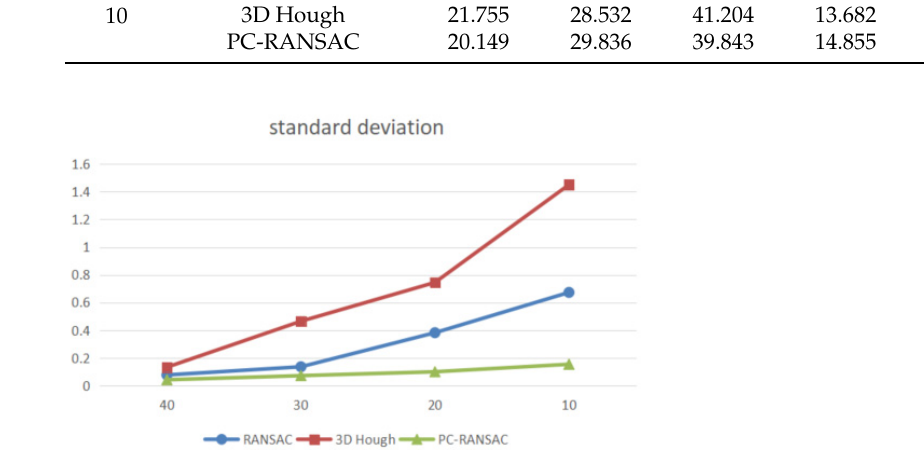
Figure 5. The standard deviation of sphere parameters estimated by different methods of simulation